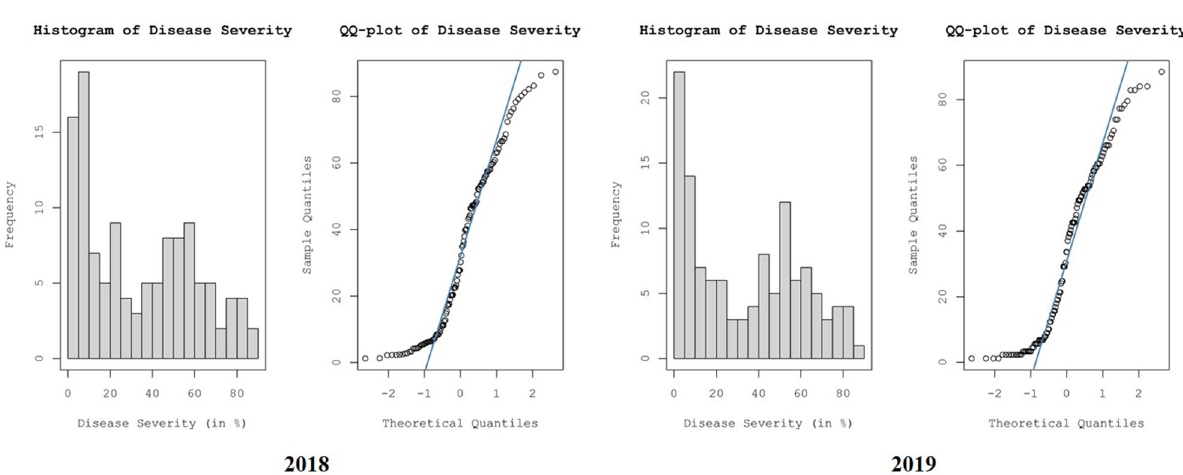
Figure 9. Histograms and normal QQ plots of RBD severity to understand the distribution of the